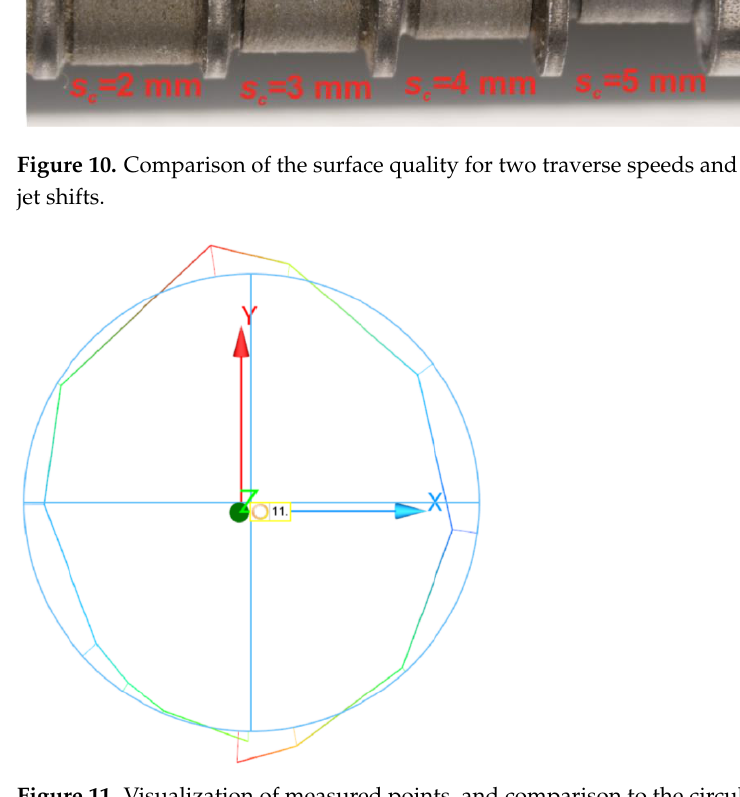
Figure 10. Comparison of the surface quality for two traverse speeds and several cumulative lat- eral jet shifts.